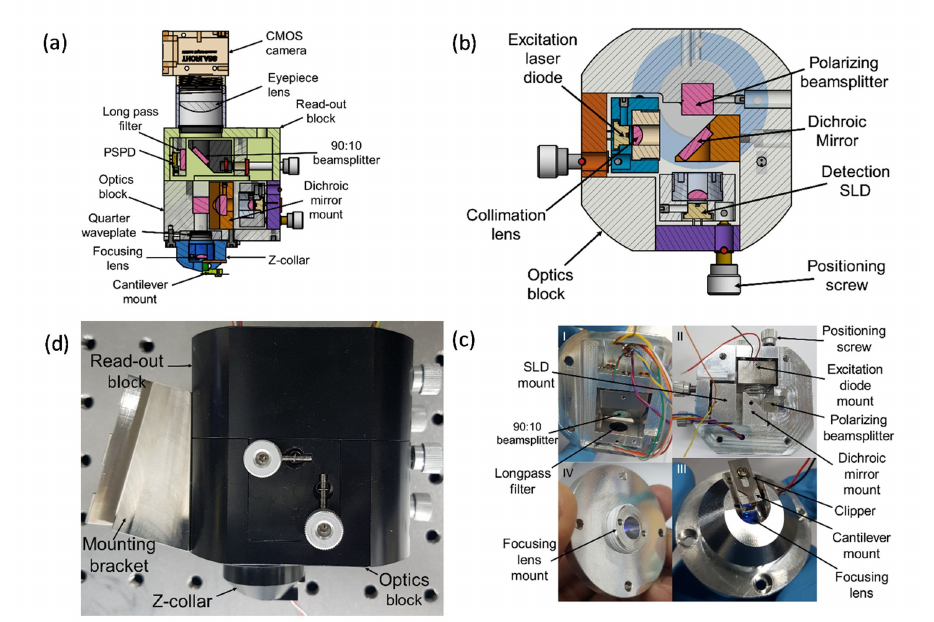
Figure 2. HS-AFM scan-head design. ( a ) A vertical section of 3D CAD model; ( b ) A horizontal section of the optics block; ( c ) Assembled scan-head components: I. read-out block, II. optics block, III. Z-collar, and the focusing lens mount partially mounted in the Z-collar. The focusing lens mount can be translated vertically within the Z-collar to place a focal spot on the cantilever; ( d ) Assembled scan-head with the mounting bracket